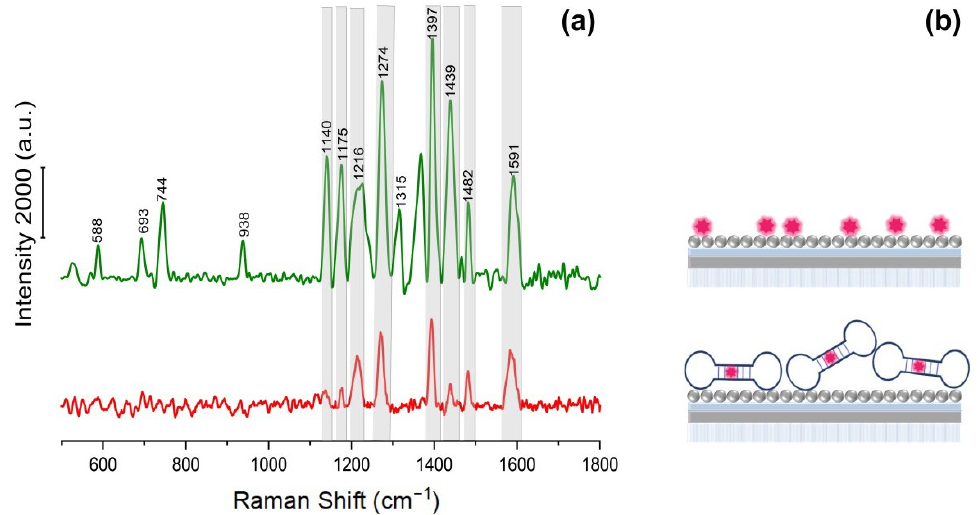
Figure 4. ( a ) SERS spectrum of Cy3 (green) and Cy3-aptamer mixture (red) on the obtained hybrid plasmonic substrate. ( b ) Scheme of the distribution of Cy3 and Cy3-labeled aptamer on a SERS-active hybrid structure.